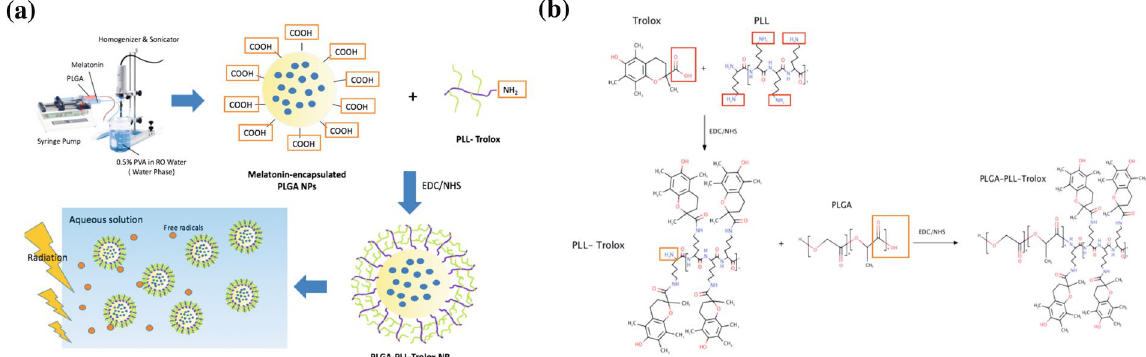
Figure 1. Design of PolyRad with the core of PLGA particles conjugated with PLL and Trolox. ( a ) Schematic of solvent diffusion method to synthesize melatonin encapsulated PLGA nanoparticles. (b) The surface of